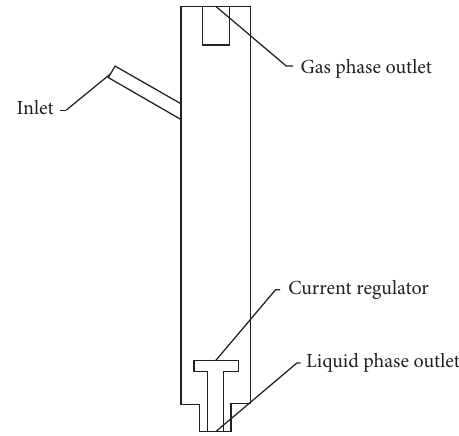
Figure 1: The structure diagram of a classical cylindrical cyclone separator.